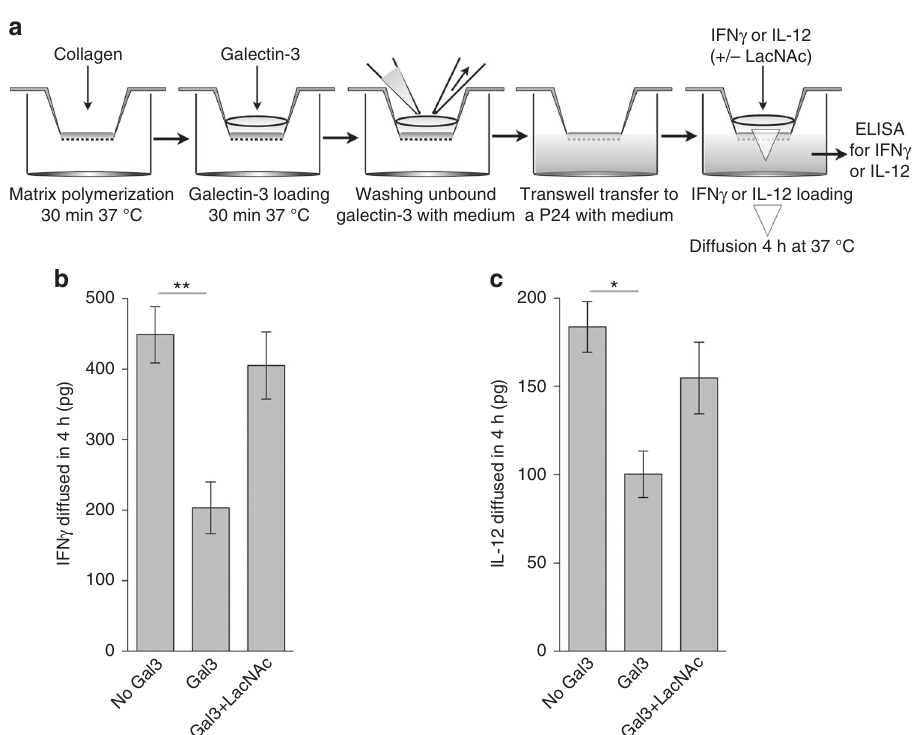
Fig. 2 Reduced diffusion of glycosylated human IFN γ and IL-12 through galectin-3-loaded collagen matrices. a Schematic drawing of the protocol. Galectin-3 (1 μ g per transwell), IFN γ (25 ng per transwell), IL-12 (7 ng per transwell), and LacNAc (1.2 mg per transwell). b IFN γ diffusion through collagen in 4 h was measured by ELISA. Mean ± SD of three experiments performed in duplicates. P = 0.006; Kruskal – Wallis test with Dunn ’ s Multiple Comparison Correction Test. c IL-12 diffusion through collagen after 4 h was measured by ELISA. Mean ± SD of three experiments performed in duplicates. P = 0.032; Kruskal – Wallis test with Dunn ’ s Multiple Comparison Correction